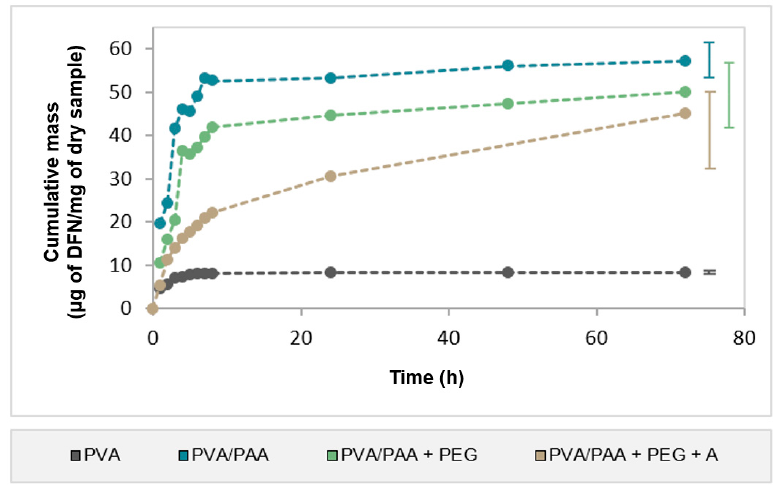
Figure 7. Cumulative drug release profiles from samples loaded with DFN. Error bars are the ± standard deviations, n = 4.